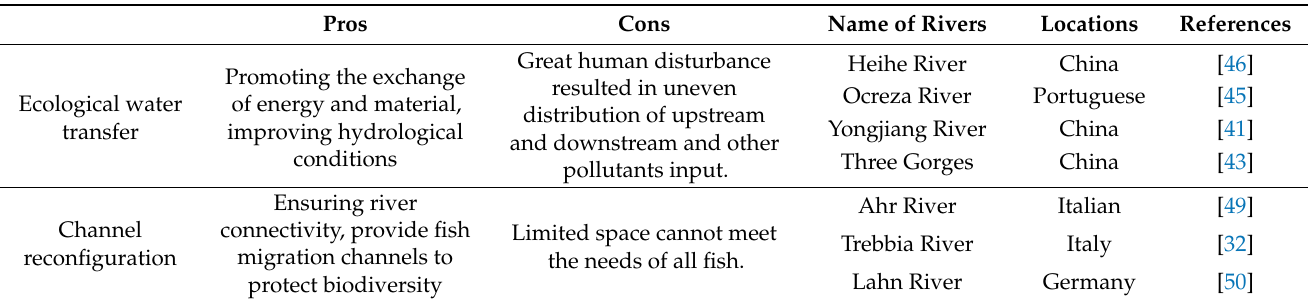
Table 1. Application of hydrological technologies in different areas. Pros